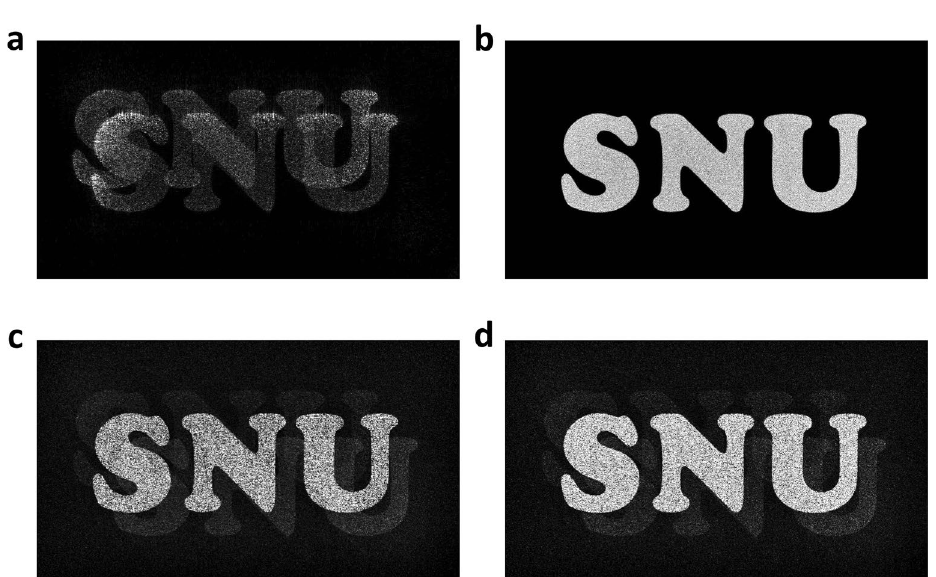
Figure 6. Simulation results considering two directional waves. Reconstructed images from ( a ) a conventional non-optimized CGH and ( b ) an optimized CGH. The simulation result of reconstructing the optimized CGH ( c ) with one plane wave and ( d ) the other plane